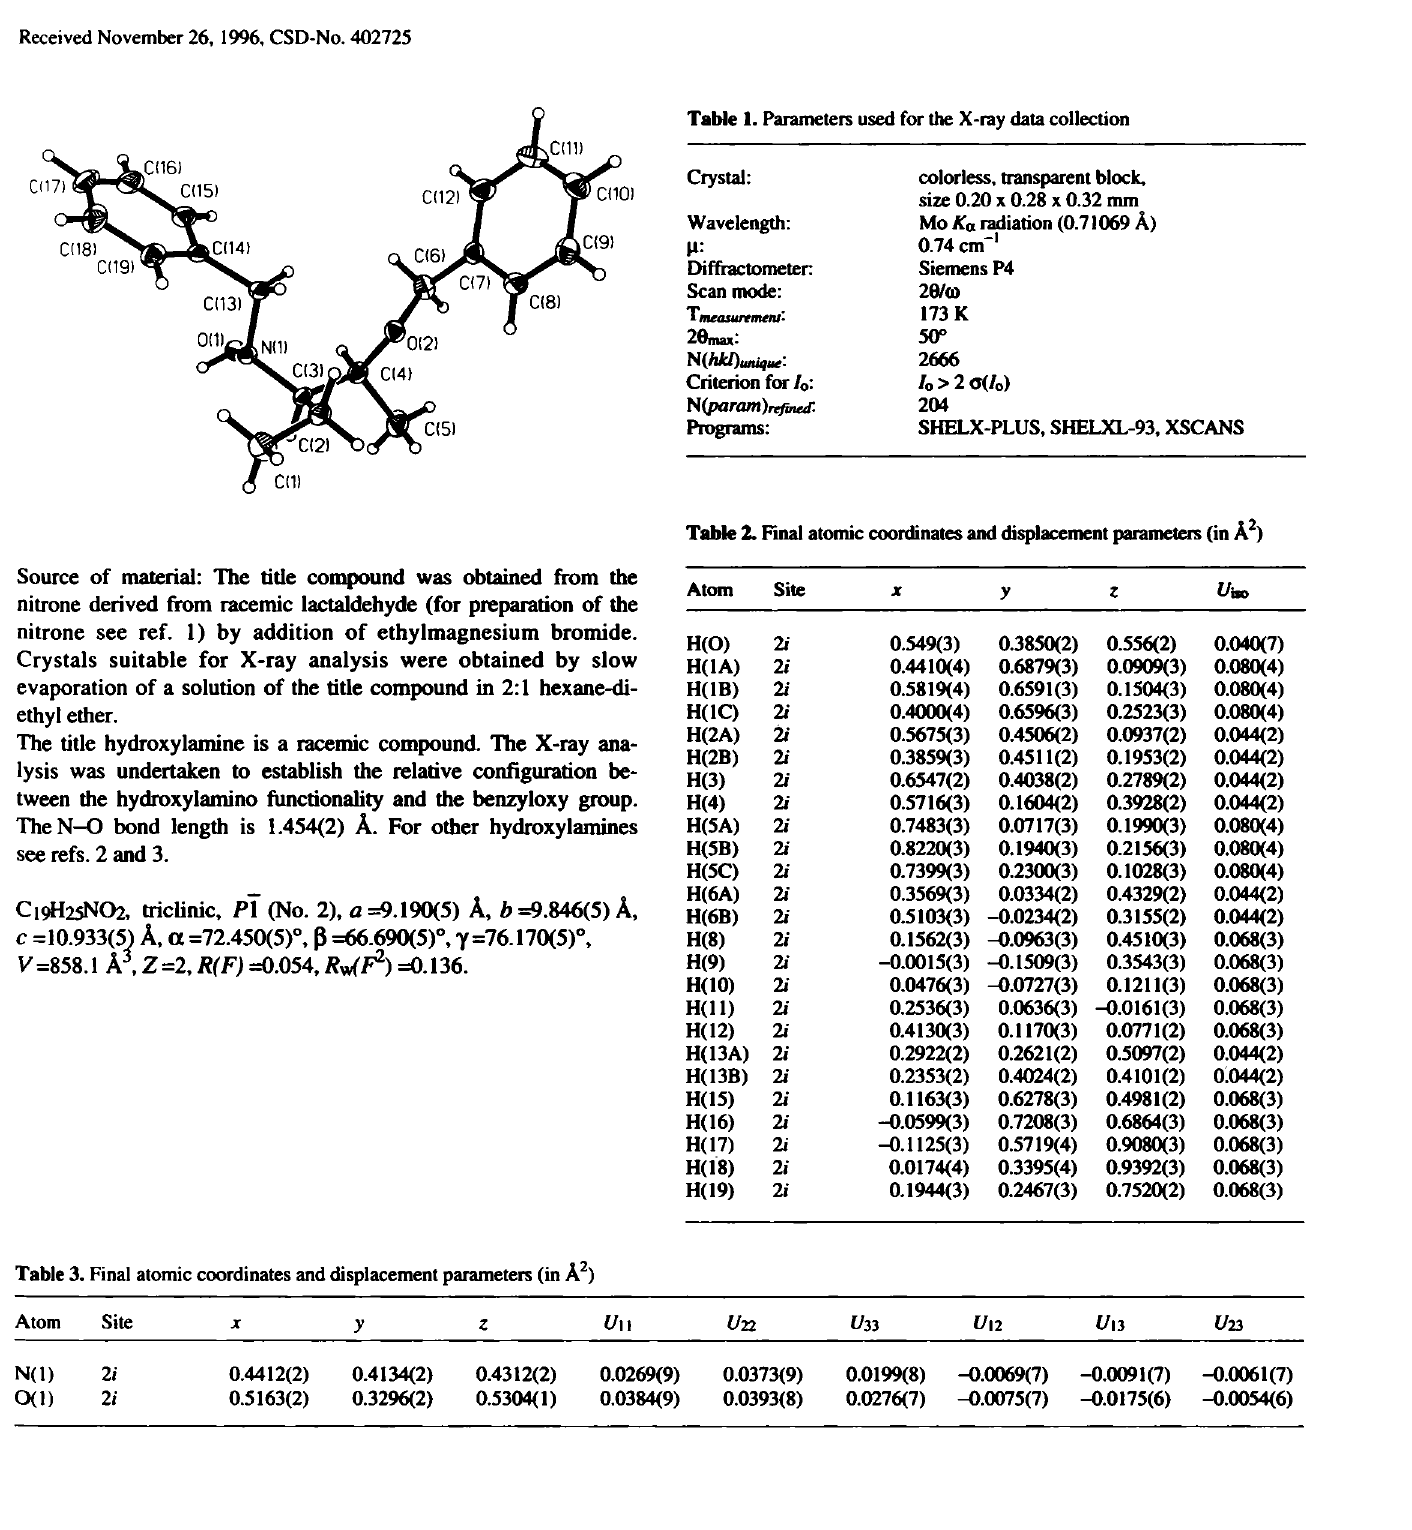
Table 1. Parameters used for the X-ray data collection Crystal: